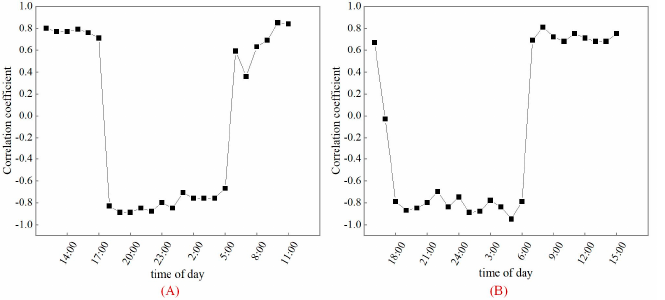
Figure 8. Correlation coefficient between OFT and BTD: ( A ) in summer; ( B ) in autumn.